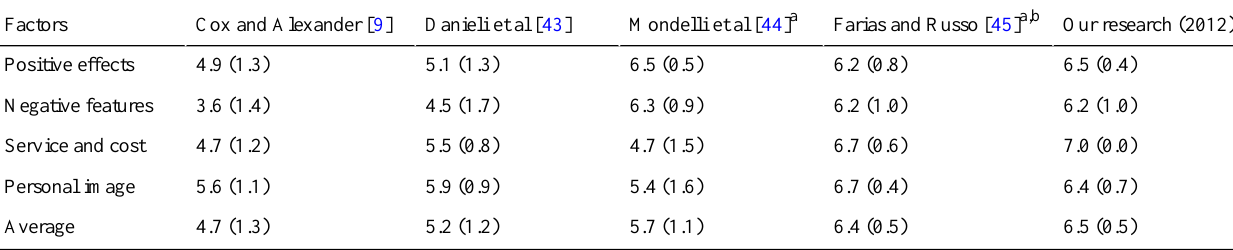
Table 9. Results of our SADL compared with four other works (mean score and